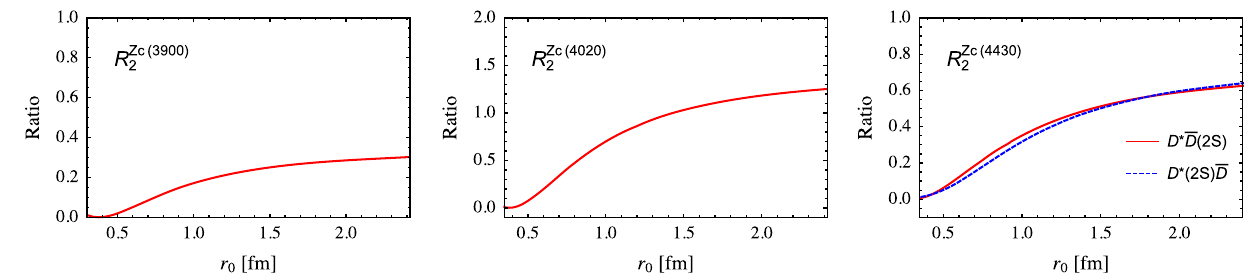
Fig. 3 The r 0 -dependence of the branching fraction ratios for Z c ( 3900 ) , Z c ( 4020 ) and Z c ( 4430 ) decaying into J /ψπ and ψ( 2 S )π Fig. 4 The r 0 -dependence of the branching fraction ratios for Z b ( 10610 ) and Z b ( 10650 ) decaying into ϒ( nS )π , h b ( 1 P )π and h b ( 2 P